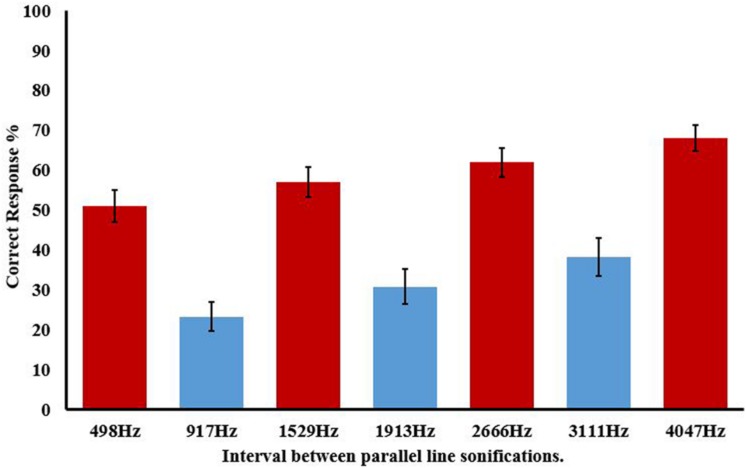
Correct response (%) for parallel line discrimination with after categorization into consonant (blue) and dissonant (red) groups. Frequency ranges for each interval are shown on the x-axis. Error bars show ±1 SEM.